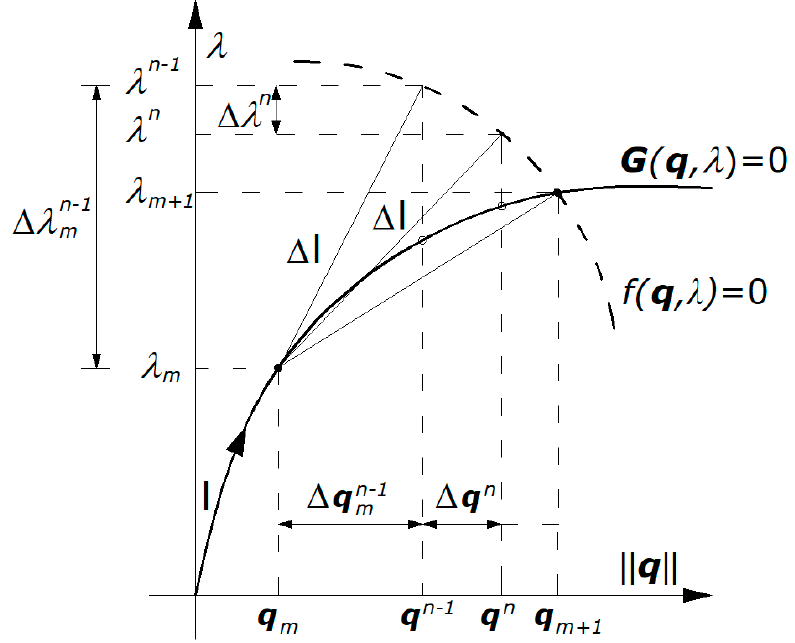
Figure 7. Iterative scheme for solving the system of extended equations.